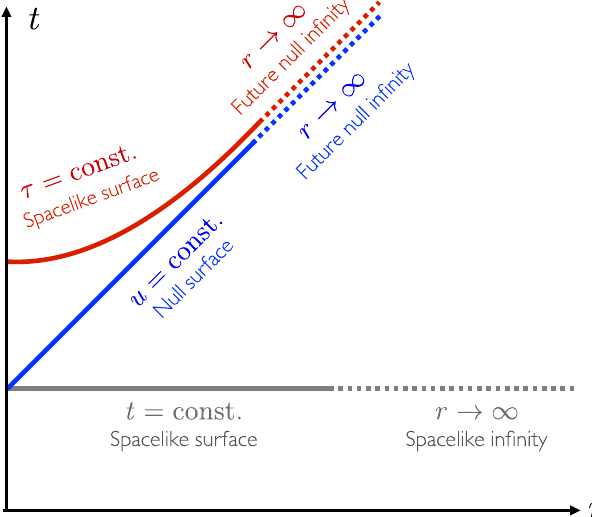
FIG. 1. Schematic representation of the different “ r → ∞ ” limits along curves within different types of spacetime hyper- surfaces. Cauchy hypersurfaces, of spacelike character and represented by the “ t ¼ const ” condition in the figure, are such that this limit attains the so-called spatial infinity i 0 , whereas in null hypersurfaces satisfying “ u ¼ const ” (with u ¼ t − r a null “ retarded time ” ) the limit attains the outgoing wave zone modeled by future null infinity I þ . The hyperboloidal approach offers an intermediate possibility, where the limit is taken along spacelike hypersurfaces, formally represented by the “ τ ¼ const ” but still reaching I þ